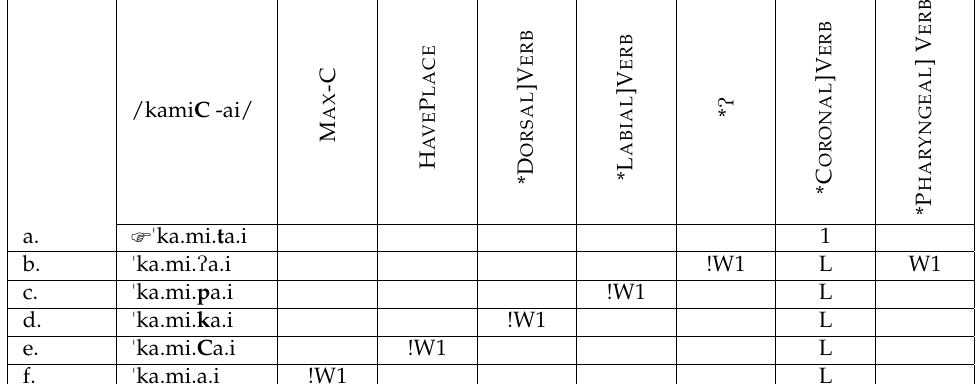
Table 1. /kami C -ai/ → [ " k á .mi. t a.i] ‘(s/he) is straining to lift (it)’ (Shipibo-Konibo).